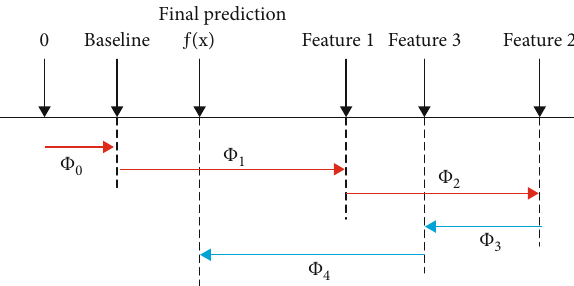
Figure 5: Schematic diagram of a four-feature SHAP